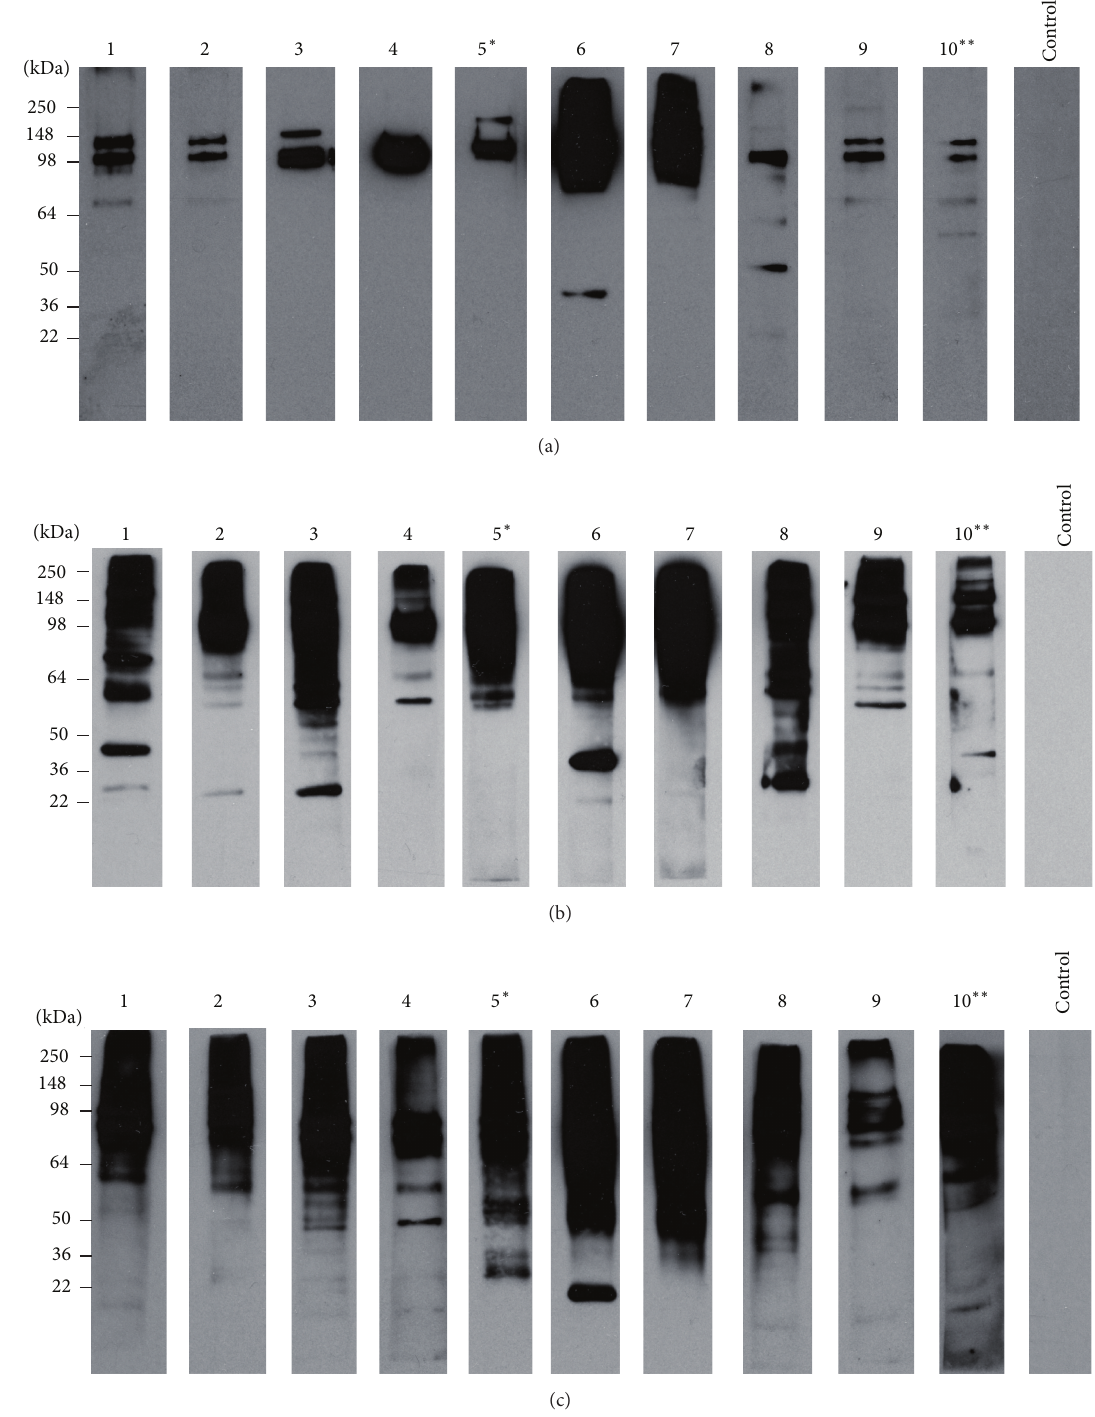
Figure 5: Humoral response of BALB/c mice after immunization with purified PyL antigens and Freund’s adjuvant. The reactivity of sera obtained from mice previously immunized with highly affinity-purified antigens plus Freund’s adjuvant ( 𝑛 = 10 ) was assayed on immunoblots of total P. yoelii blood-stage antigen (10 𝜇 g/lane) at days 40 (a), 70 (b) and 100 (c). A representative nonvaccinated mouse serum (Control) served as the negative control at corresponding day. Two weeks after last immunization mice were infected with PyL and mouse number 5 ∗ survived the infection and mouse number 10 ∗∗ lived until day 17 pi. Antigen-specific antibodies were detected with anti-mouse IgG/HRP linked